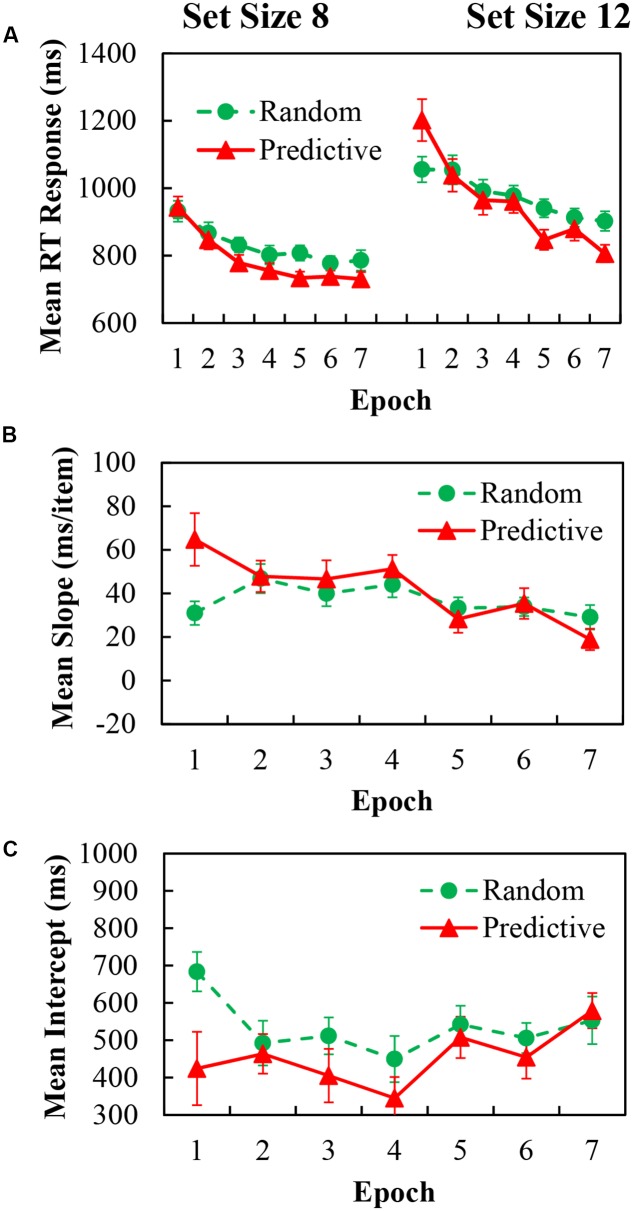
(A) Mean correct RTs in each epoch for predictive (red) and random (green) configurations in set size 8 (Left) and set size 12 (Right) of Experiment 3. (B) Search slopes (ms/item) for predictive (red) and random (green) configurations over epoch of Experiment 3. (C) Intercepts (ms) for predictive (red) and random (green) configurations over epoch of Experiment 3.